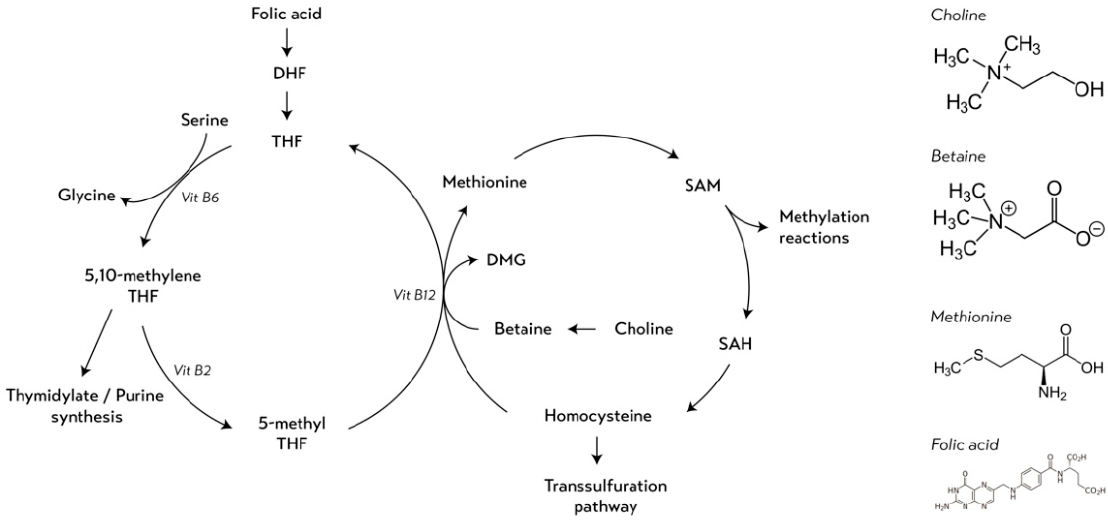
Figure 1. Simplified schematic overview of the one-carbon metabolism and the chemical structures of the methyl-group donors. Abbreviations: DHF: dihydrofolate; THF: tetrahydrofolate; Vit B6: vitamin B6; Vit B2: vitamin B2; Vit B12: vitamin B12; DMG: dimethylglycine; SAM: S-adenosylmethionine; SAH: S-adenosylhomocysteine.